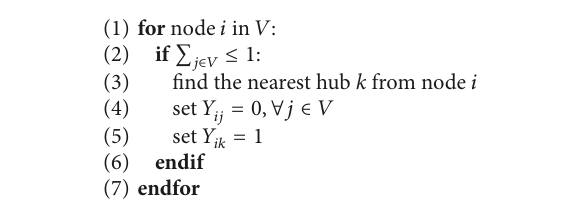
Algorithm 2: Finding the upper bound for Lagrangian